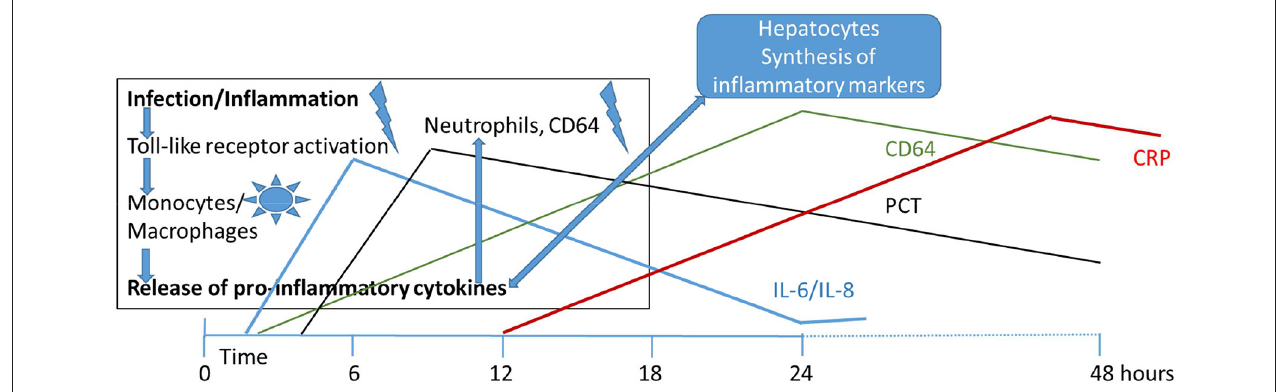
FIGURE 1 | Initiation of infectious/inflammatory processes and release of inflammatory markers over the first 48h of life in early onset neonatal sepsis. IL, interleukin; PCT, procalcitonin; CRP, C-reactive protein; CD64, cluster of differentiation (neutrophil surface expression).